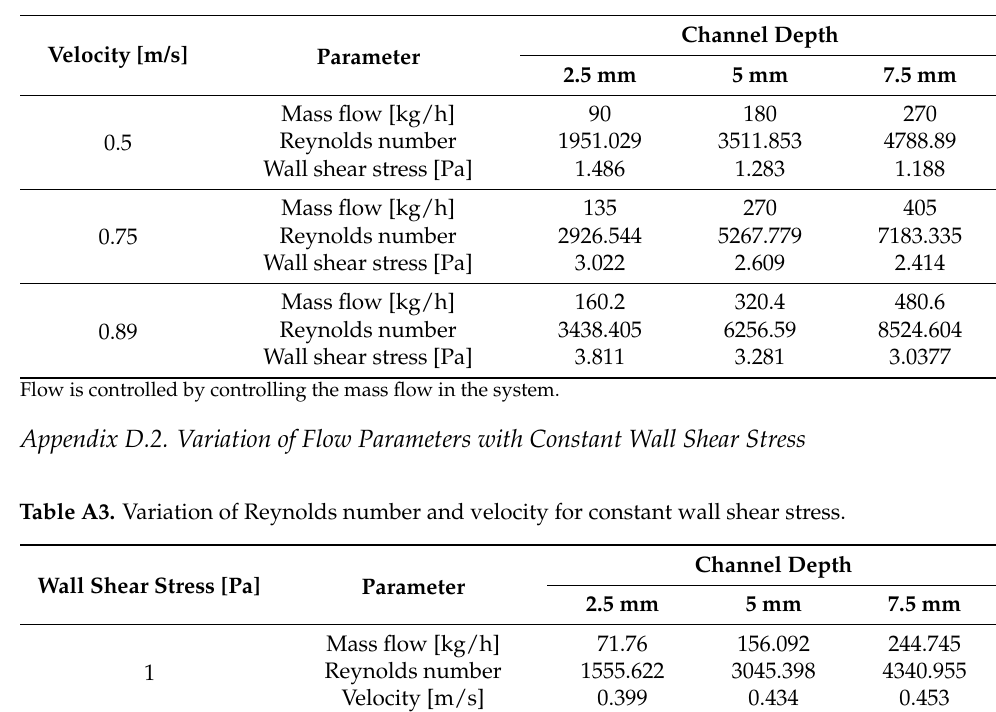
Table A2. Variation of Reynolds number and wall shear stress for constant velocity.